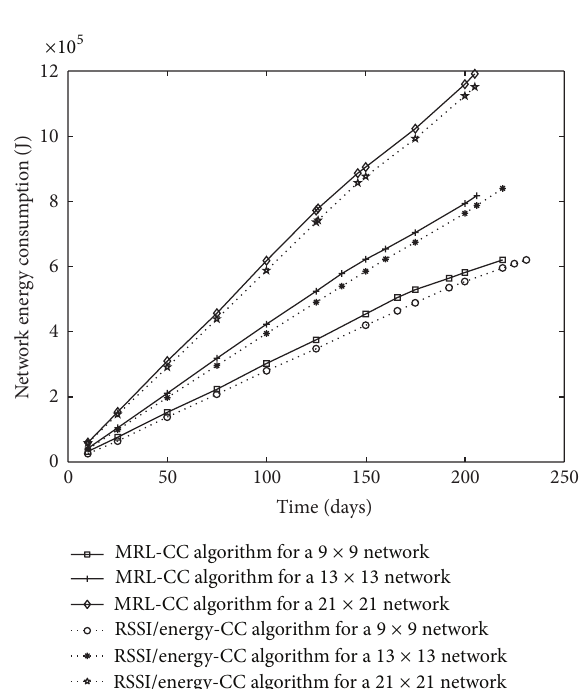
Figure 10: Network energy consumption, comparison between network architectures for MRL-CC and E/RSSI CC algorithms.